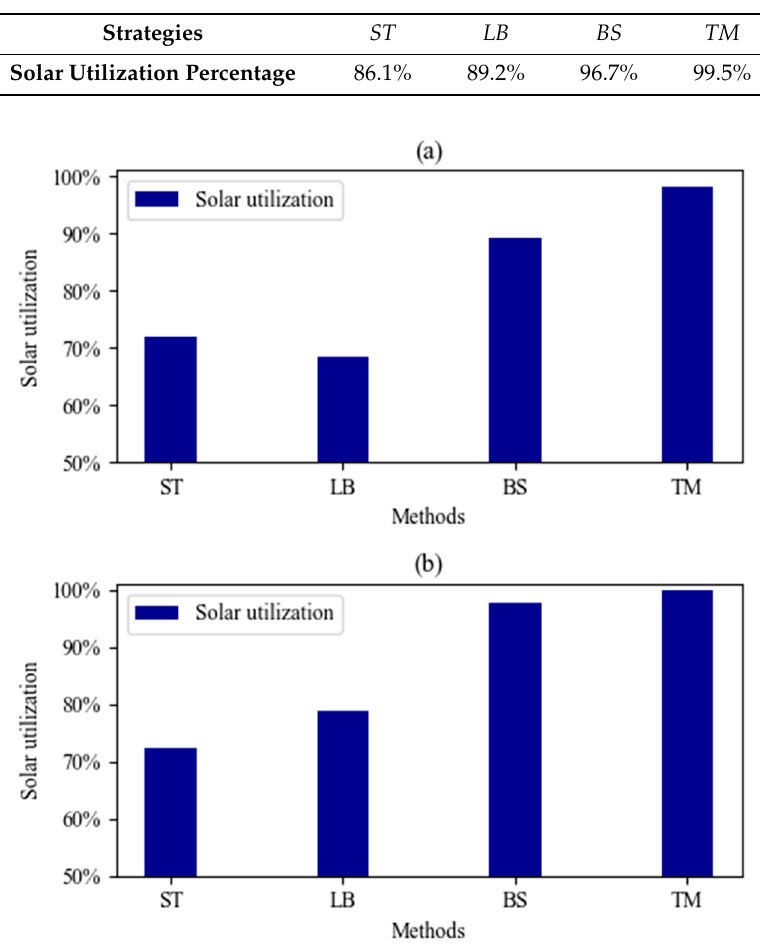
Table 3. Solar utilization percentage under cloudy (rainy) weather condition.